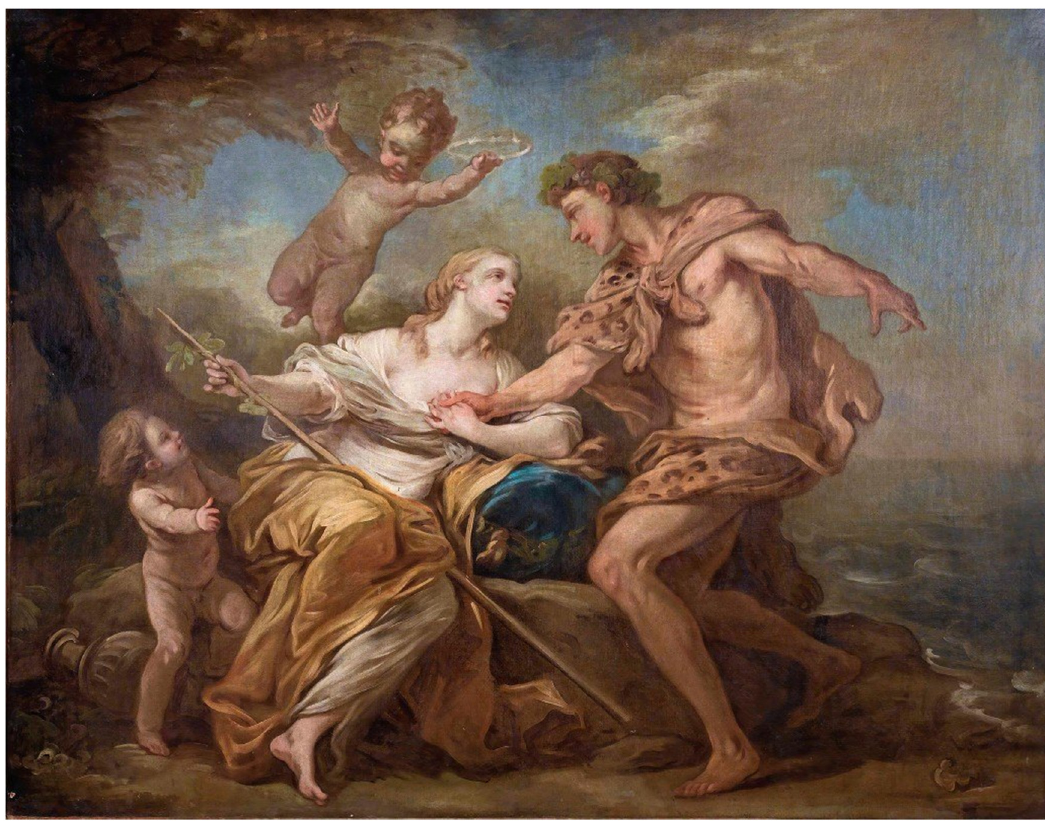
Figure 32: Carle van Loo, Bacchus and Ariadne. Painted in Turin, 1732 – 1734.